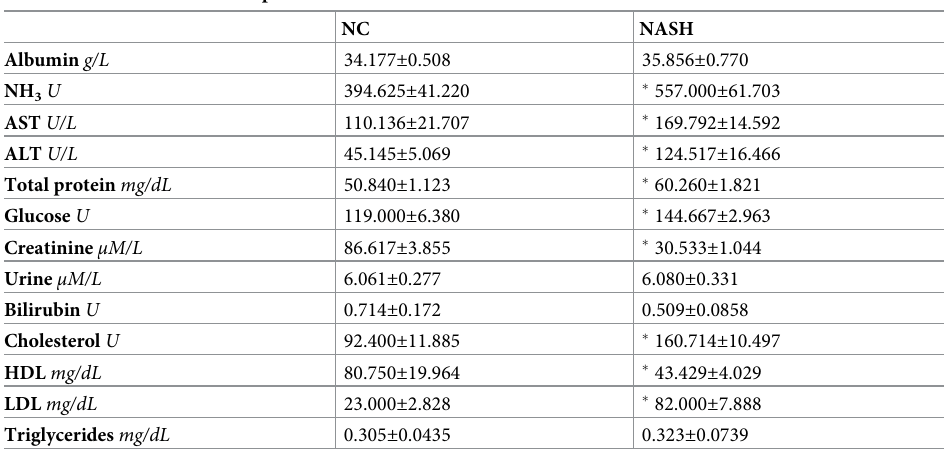
Table 2. Biochemical values in plasma.